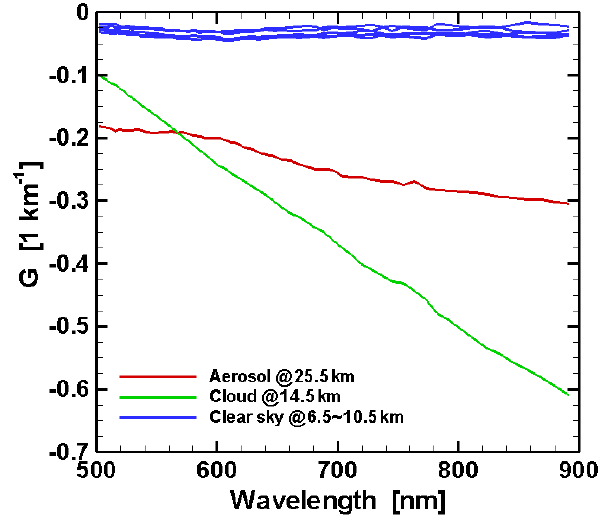
Figure 1. Variations in the radiance gradient G(λ,z) from OMPS/LP data at 5 ◦ S during orbit 16754 on 21 January 2015. Blue: clear sky; green: cloud; red: